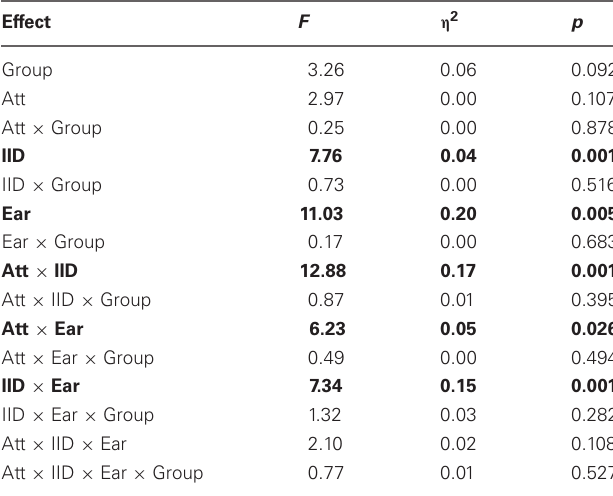
Table 2 | Behavioral data analysis for the dichotic listening task for NCH group and control